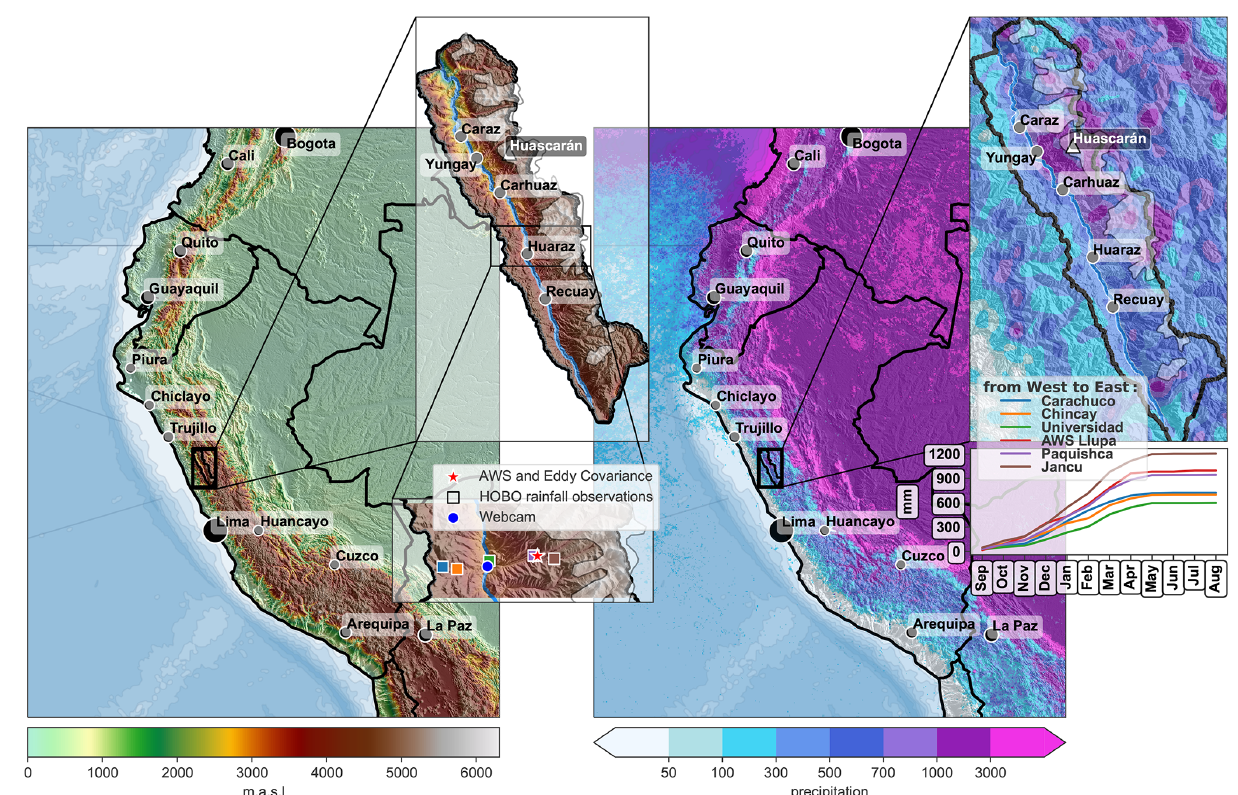
Figure 1. Left: Overview of the topography (based on SRTM data, USGS EROS Archive, 2021). Important towns are shown (relative population by marker size). Black box marks RSB location and inset shows upper RSB including most important towns. Blue line indi- cates the Santa river; the range west (east) of the river is the Cordillera Negra (Blanca). Approximate glacier outlines are shown in white polygons. Small inset panel shows locations of rainfall observation transect by the AgroClimHuaraz (https://agroclim-huaraz.info/, last ac- cess: 15 March 2022) project. Right: TRMM rainfall climatology (Bookhagen and Strecker, 2008) shows rainfall gradient over central-west South America and the RSB (inset). Lower right-hand inset roughly illustrates the east–west precipitation gradient in the RSB of rain gauge observations (cumulative rainfall, averaged from 2016 to